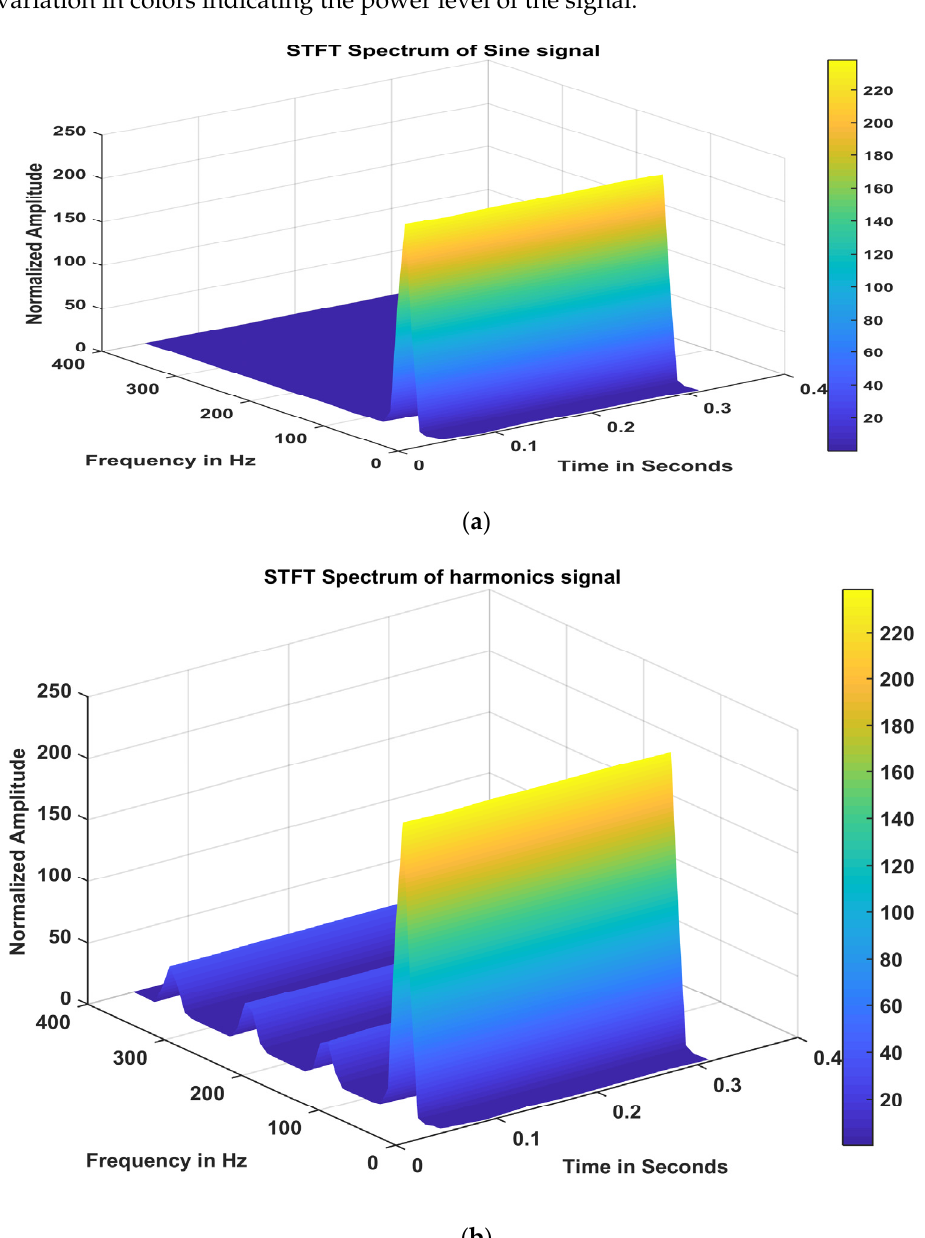
Figure 4. ( a ) STFT spectrum of sine signal. ( b ) STFT spectrum of harmonics signal. Information obtained from the spectrogram of sine and harmonics signals can be visualized in Figure 5a,b. The strength of the supply voltage signal showing a variation in the color, according to the colormap, is displayed as a function of time for different fre- quencies.